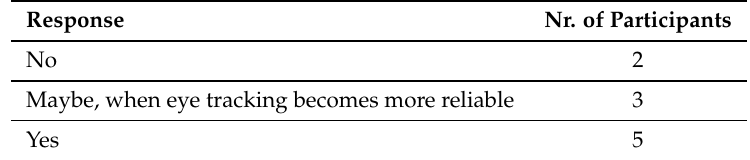
Table 5. Distribution of responses to the question “Would you consider the inclusion of an eye tracking camera in your gaming